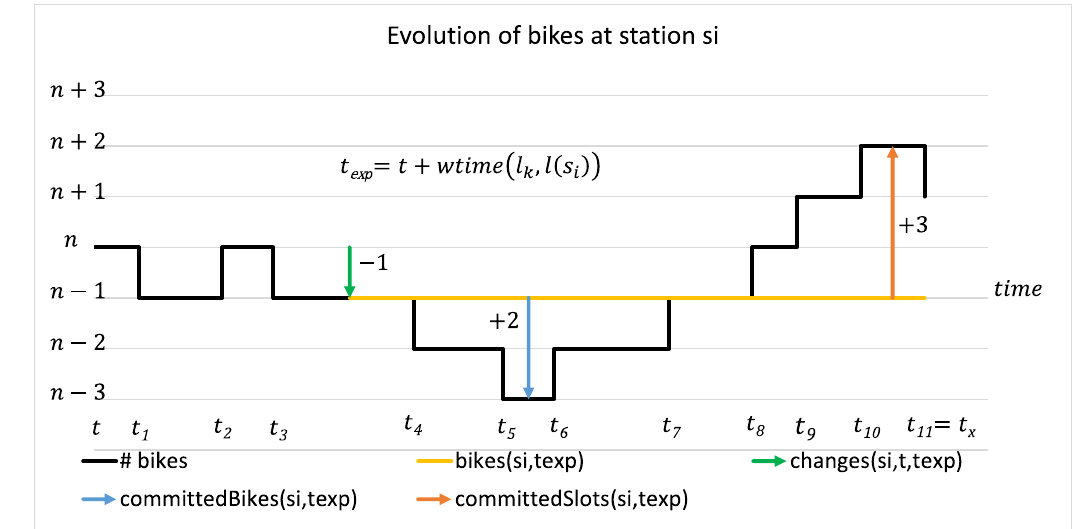
(cid:0) (cid:1) s i , t , t exp , commitedBikes , 𝑡 (cid:3439) are shown. (cid:3036) (cid:3032)(cid:3051)(cid:3043)